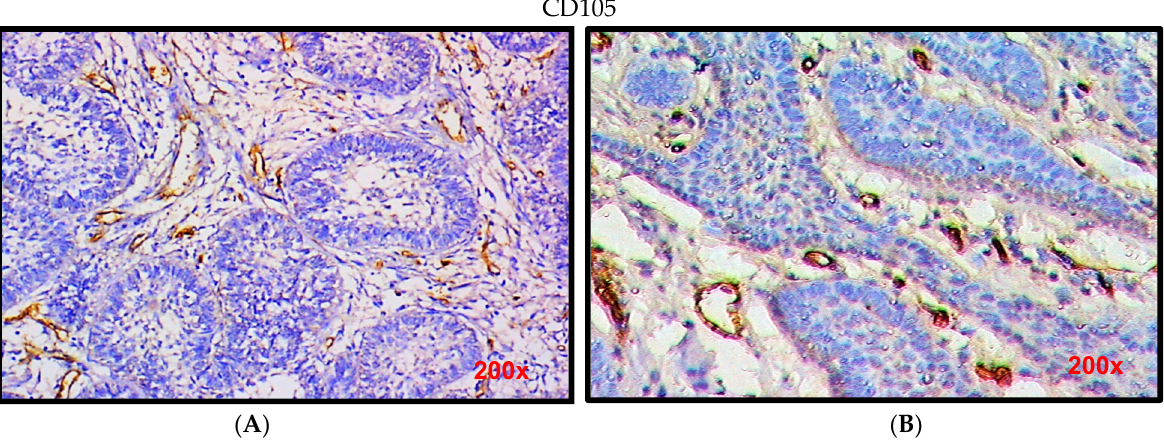
Figure 2. ( A ) Photomicrographs of ameloblastoma showing immunohistochemical staining of micro vessels adjacent to epithelial nests; ( B ) photomicrographs of ameloblastic fibroma showing immunohistochemical staining of micro vessels adjacent to epithelial islands.